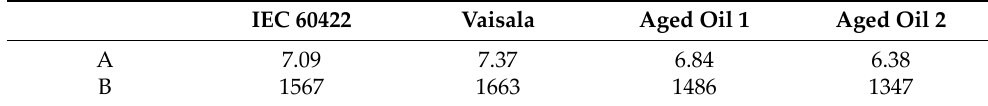
Table 3. Comparison of solubility coefficient for new and aged oil [49].